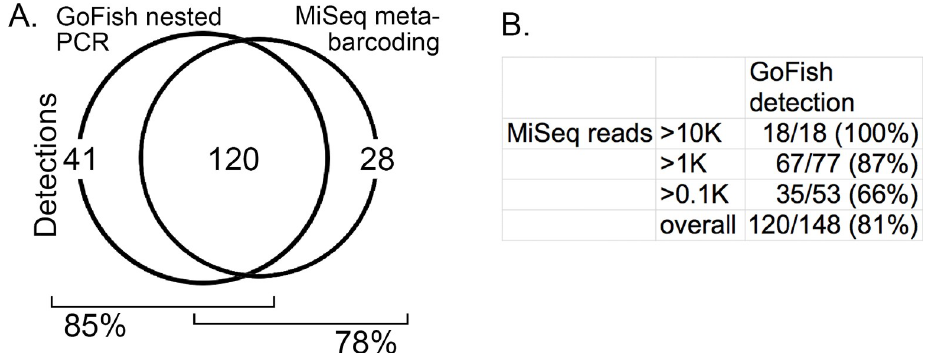
Fig 5. Comparison of GoFish and metabarcoding. A. Number of detections by method for the 11 species and 34 samples shown in Fig 3. A detection refers to a positive GoFish or metabarcoding result for a single species in a single sample, which corresponds to one cell in Fig 3 grid. Of the 161 GoFish detections shown in Fig 3, 120 were also positive by metabarcoding for the same species in the same sample. In addition, there were 28 metabarcoding detections for one of the 11 target species in samples that were negative by GoFish. B. GoFish detections for the 148 metabarcoding positives, sorted by metabarcoding reads per detection.